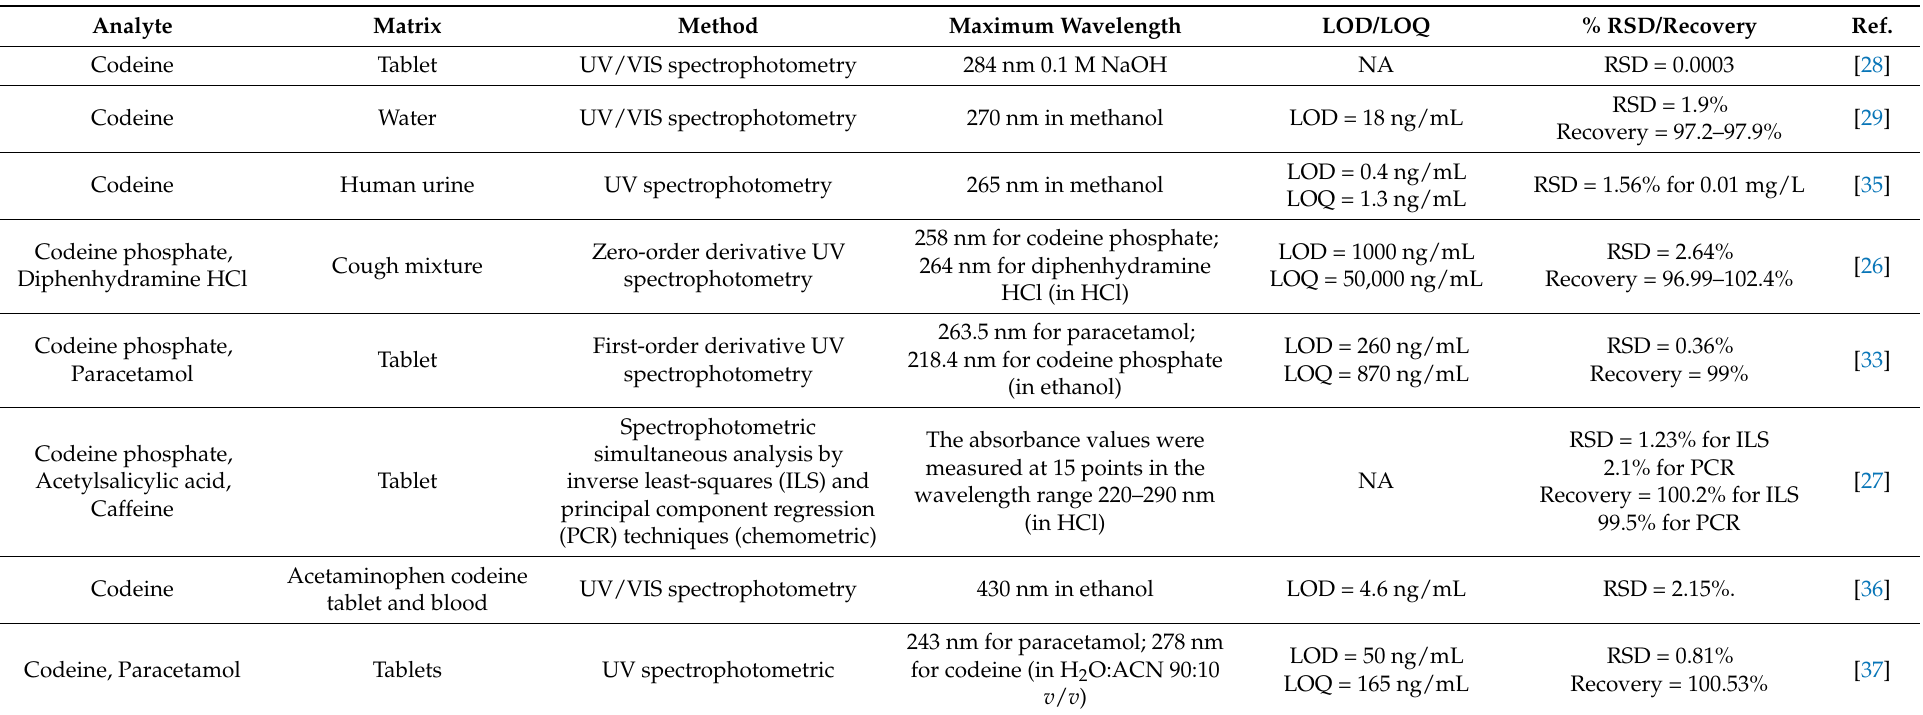
Table 2. Spectrophotometric methods for codeine